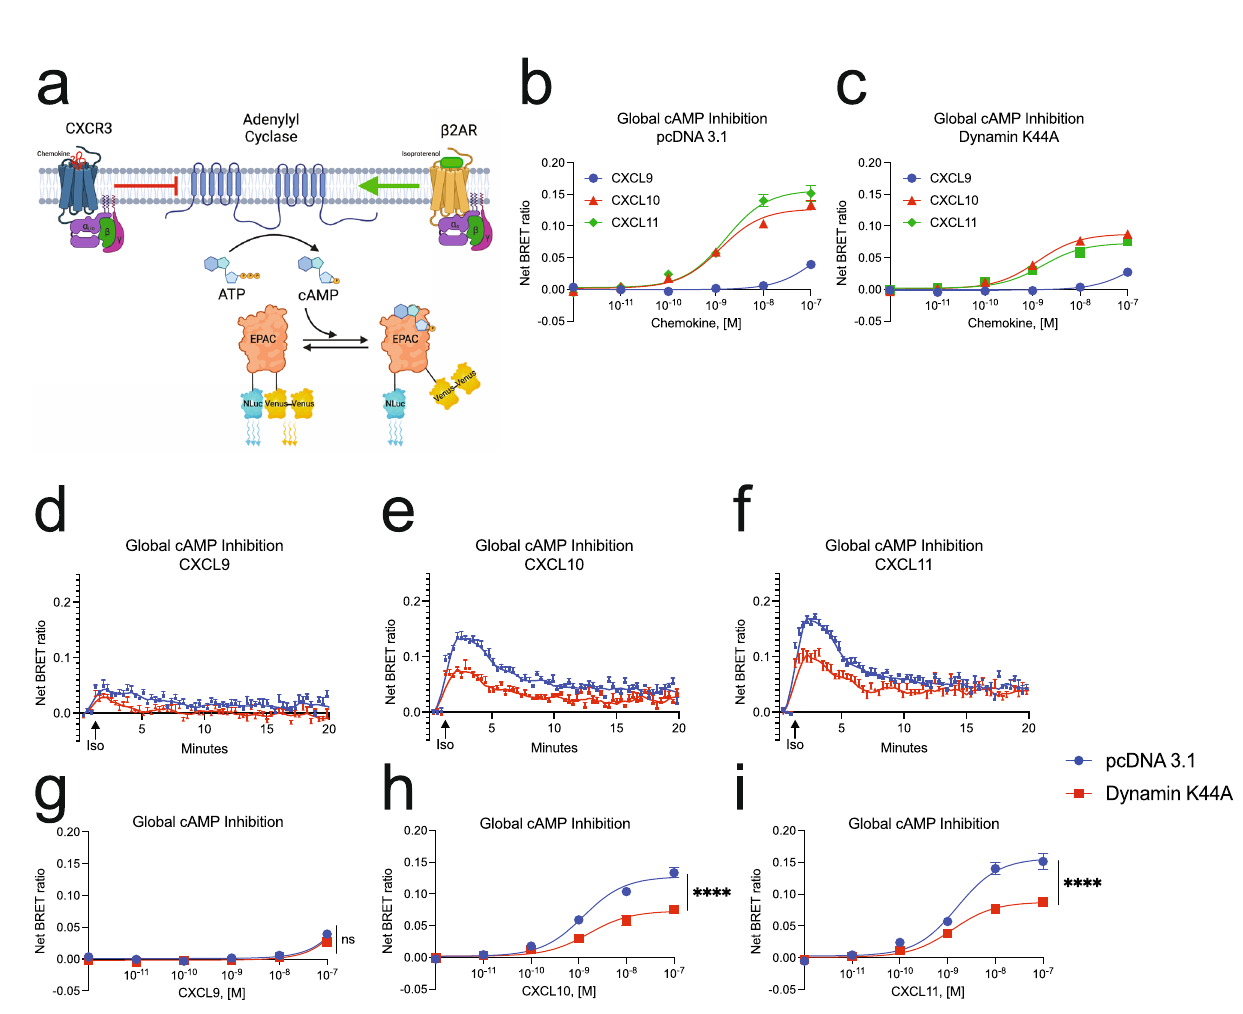
Fig. 3 | Maximal G α i mediated cAMP inhibition at CXCR3 is dependent on receptor endocytosis. a Schematic representation of the cAMP sensor experi- mental design 40 . Agonist dose-dependent inhibition of isoproterenol-induced cAMP productionby the chemokinesin HEK293 cellswith concurrent transfection of b pcDNA 3.1 or c DynaminK44Ainhibits internalizationas measured between 3- and 5-min following addition of 1 µ M isoproterenol. d – f Kinetic data of 100nM treated cells and g – i agonist dose-dependent of cAMP inhibition levels in HEK293